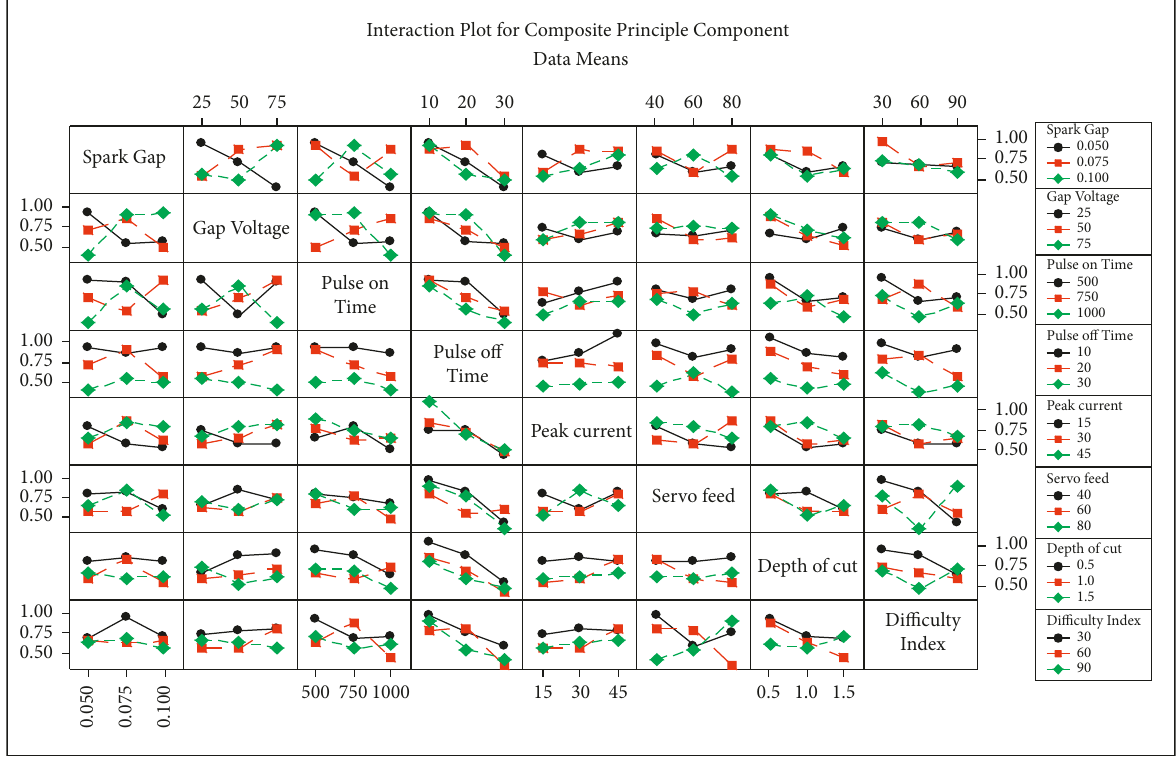
Figure 7: Interaction plot for the composite principal component.